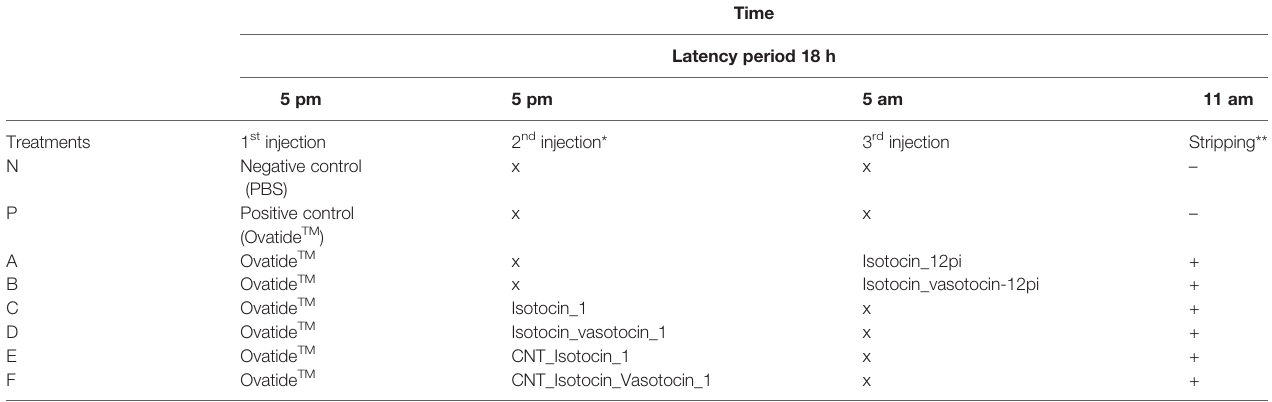
TABLE 1 | Framework of experimental